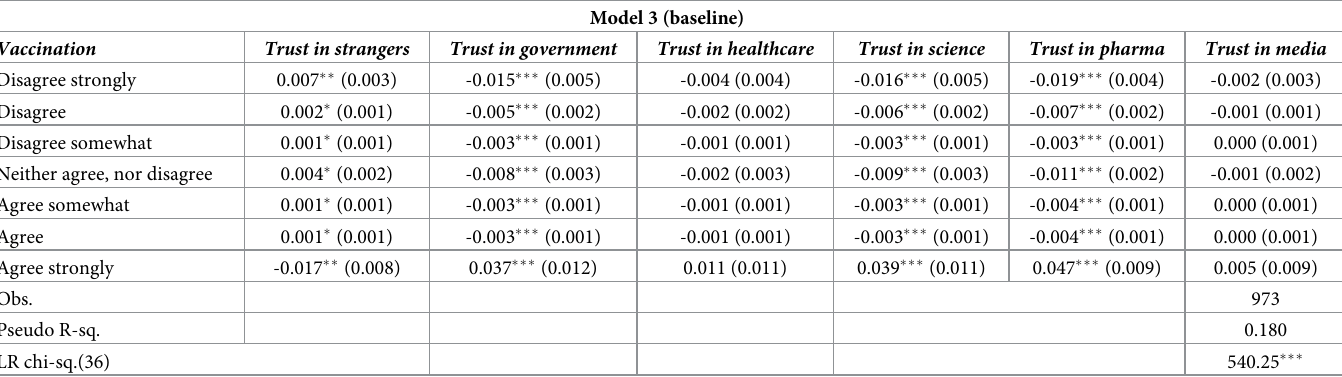
Table 3. Ordered logistic regression model with all trust variables and